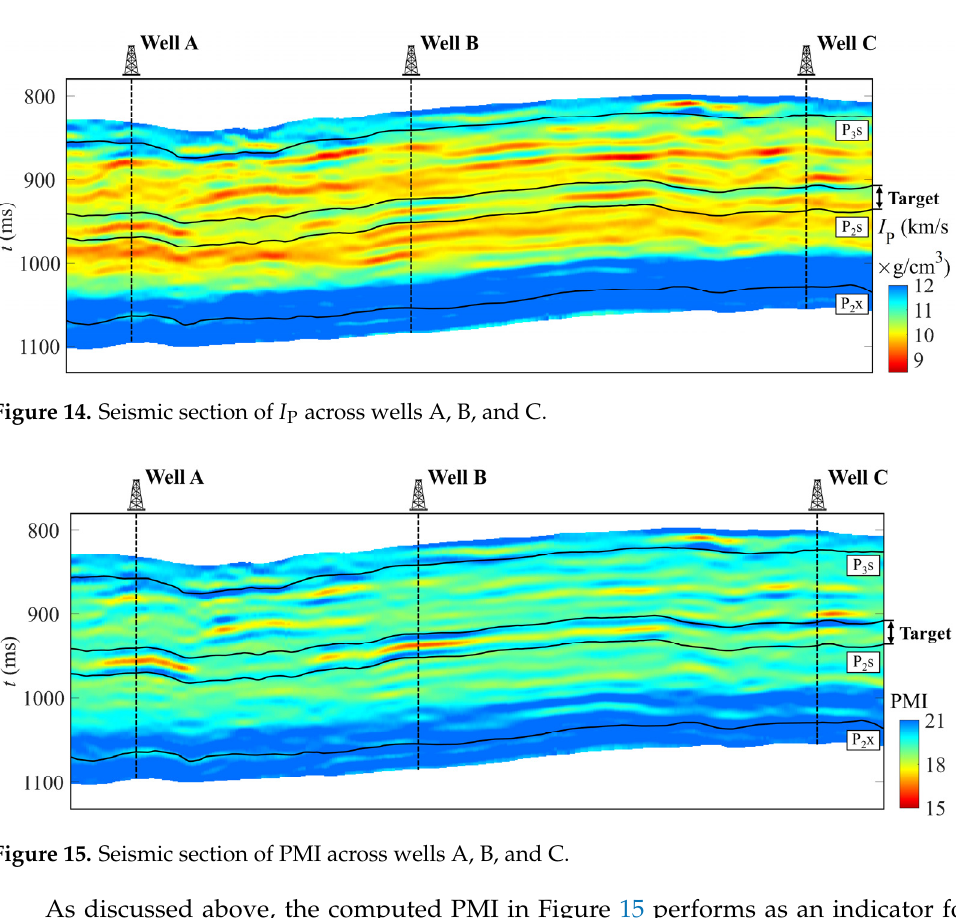
Figure 13. Seismic section of V P / V S across wells A, B, and C.